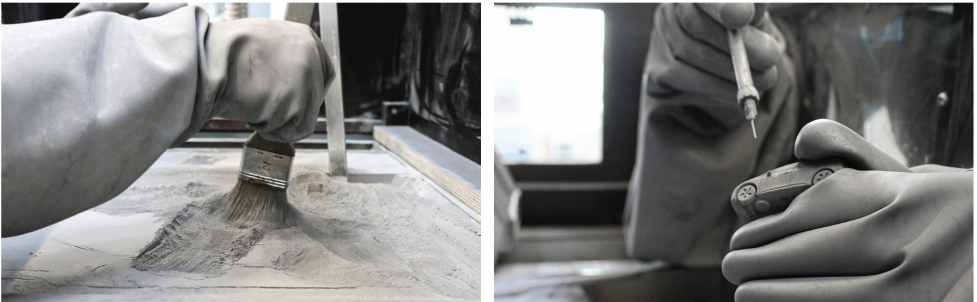
Figure 1. State-of-the-art methods for cleaning binder jetting green parts with brushes, vacuum and compressed air lance.